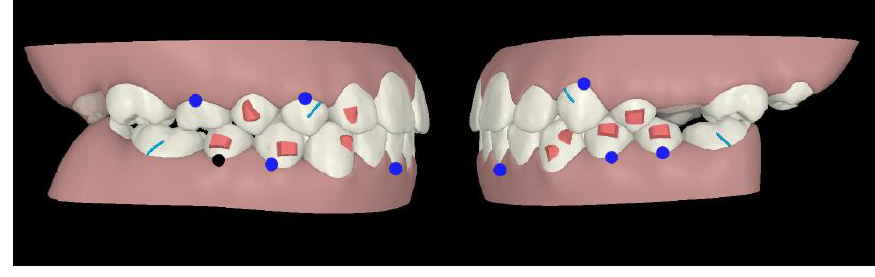
Figure 2. Treatment plan phase I.